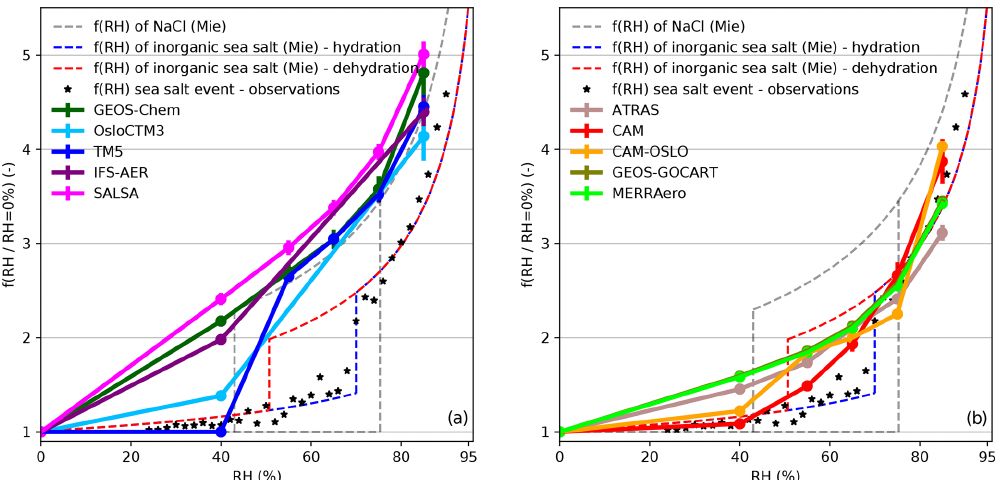
Figure 5. The scattering enhancement factor f (RH) vs. RH for sea-salt-dominated aerosol at Graciosa (GRW) as predicted by the different models ( a : GEOS-Chem, OsloCTM3, TM5, IFS-AER, and SALSA. b : ATRAS, CAM, CAM-OSLO, GEOS-GOCART, and MERRAero). The model data are shown for cases when the predicted sea salt mass fractions were larger than 95%. For comparison, the expected values for f (RH) of (i) NaCl determined by Mie modeling and (ii) for inorganic sea salt determined by Mie modeling based on a hygroscopic tandem differential mobility analyzer (H-TDMA) sea salt chamber measurements of Zieger et al. (2017) are shown. The dashed blue and red lines show the corresponding hydration and dehydration lines, respectively. Field measurements of f (RH) for pristine sea salt aerosol are shown as black stars (taken from Zieger et al.,